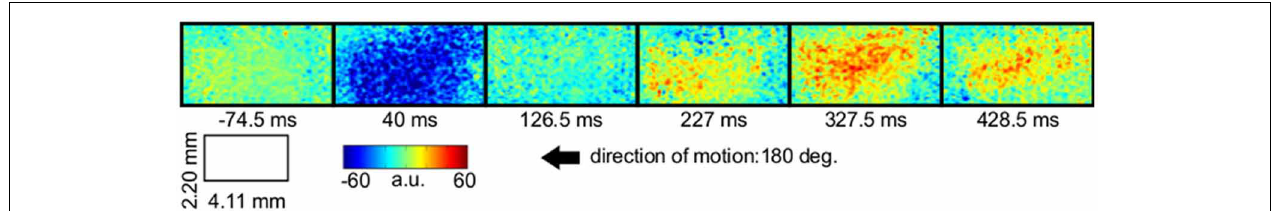
FIGURE 1 | Local active information storage (LAIS) allows to trace neural information processing in space and time. Spatio-temporal structure of LAIS in cat area 18—seven frames from the spatio-temporal LAIS data, taken at the times indicated below each frame. Stimulation onset was at time 0. Baseline activity ( − 74.5ms) is around zero and